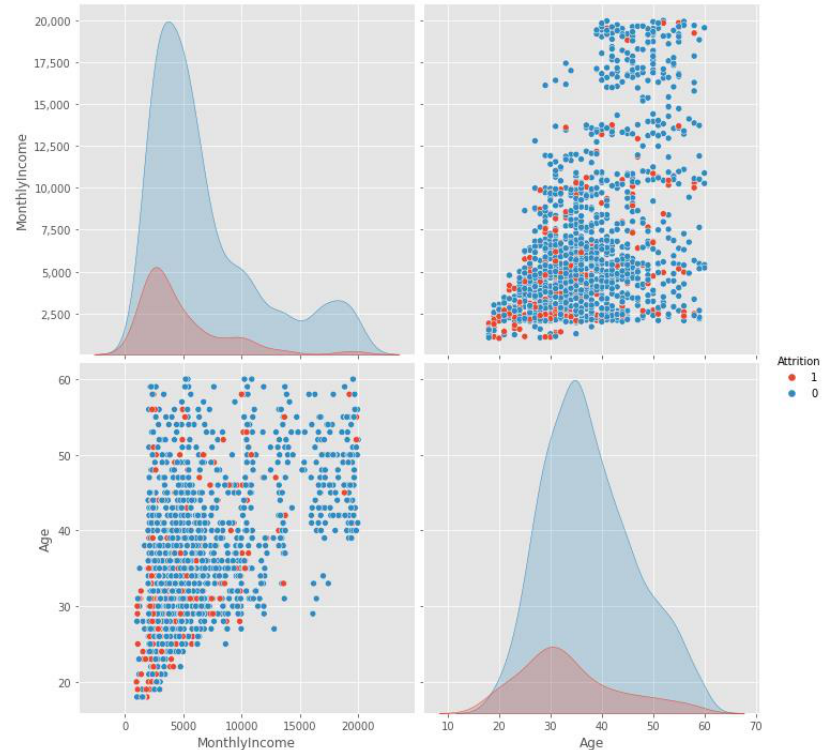
Figure 4. The monthly income and employed age analysis by employee attrition.